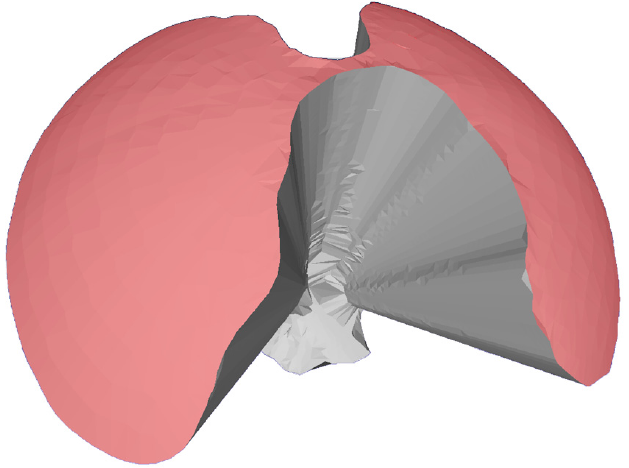
Figure 2. A rendered image from MESHLAB was used to manually select the upper area (red) to calculate the area of maneuverability. The example shows the measured volume of one SILS-port (www.blender.org, accessed on 30 April